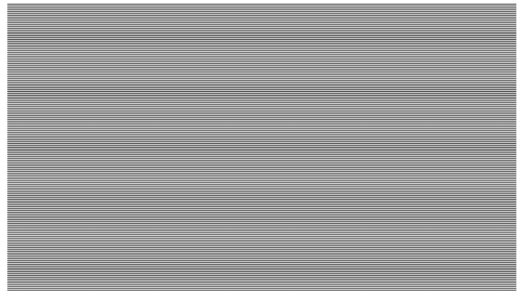
Figure 12. Simulated frame: t = 1/32,000, f -number = 2.8, L v = 16,384, ISO =